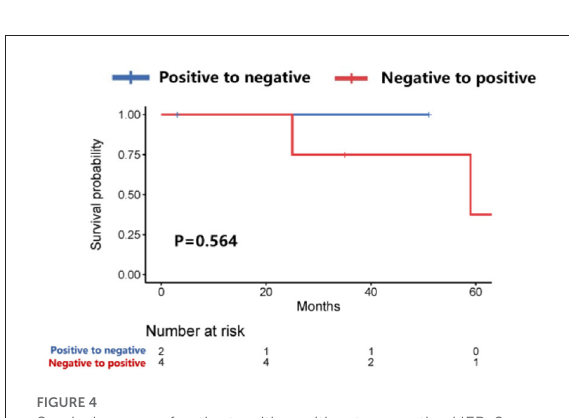
FIGURE4 Survival curves of patients with positive-to-negative HER-2 expression vs. patients with negative-to-positive HER-2 expression after diagnosis of brain metastases.